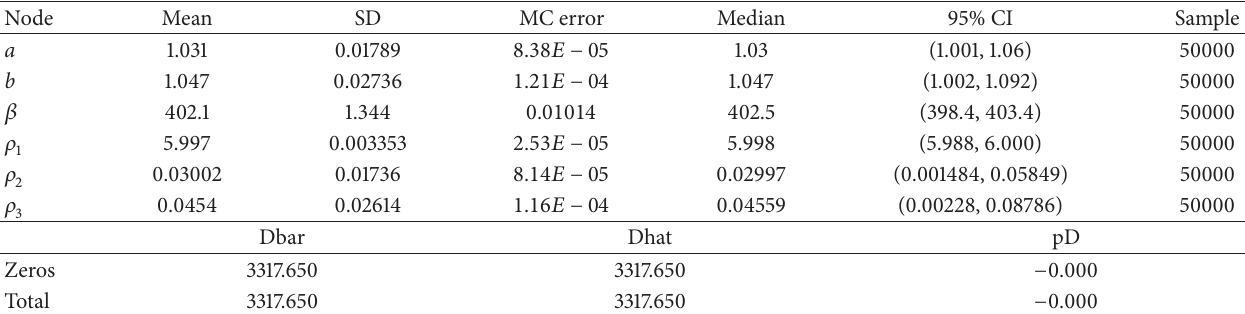
Table 7: Summary of the posterior parameters in the case of BIW for Black Hispanic females breast cancer patients ( 𝑛 = 298 ).